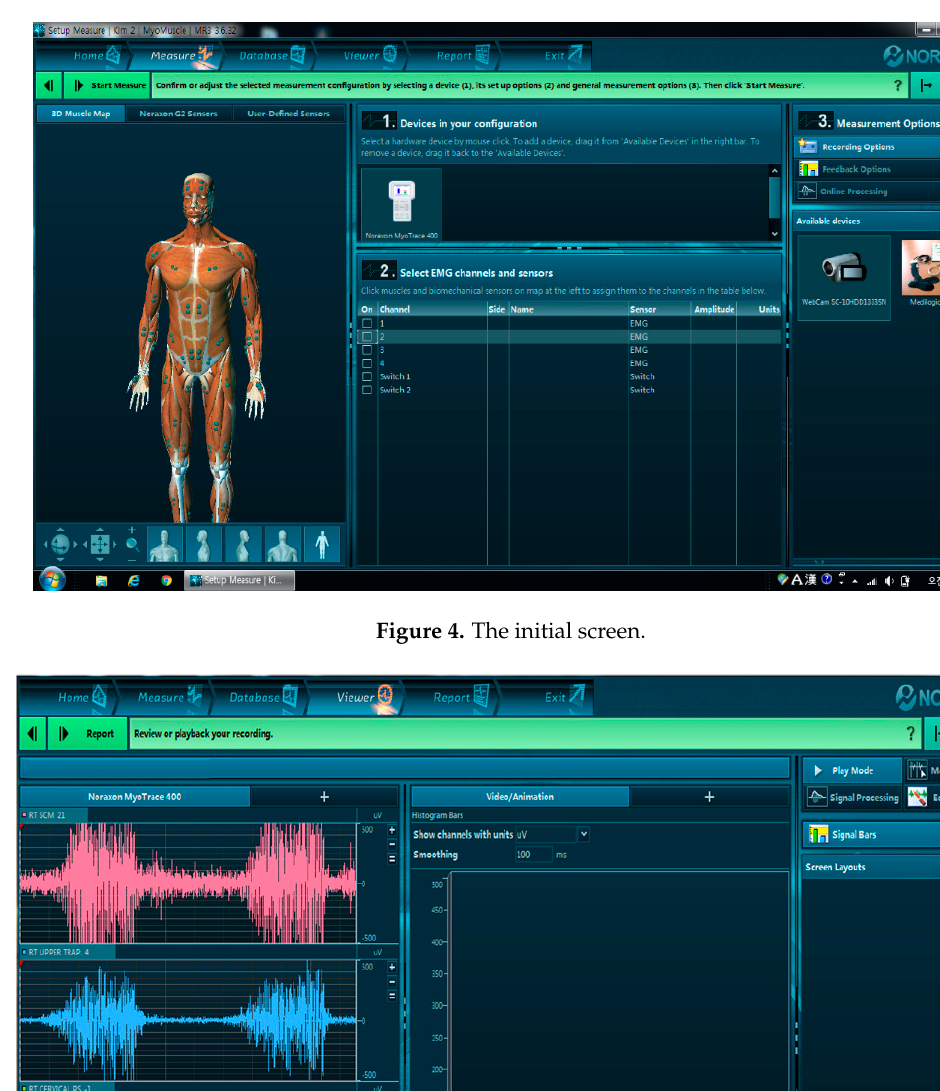
Figure 3. A schematic diagram of the isotonic contraction of the biceps brachii muscles.